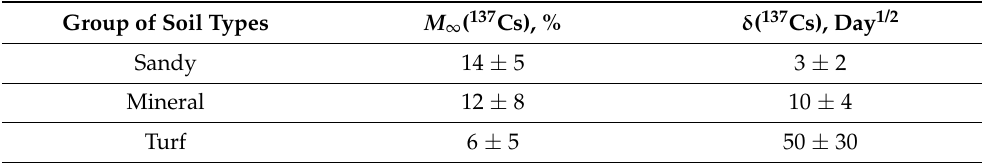
Table 2. Typical values of mobile fraction at equilibrium M ∞ ( 137 Cs) and diffusional fixation parameter δ ( 137 Cs) for basic groups of soil types